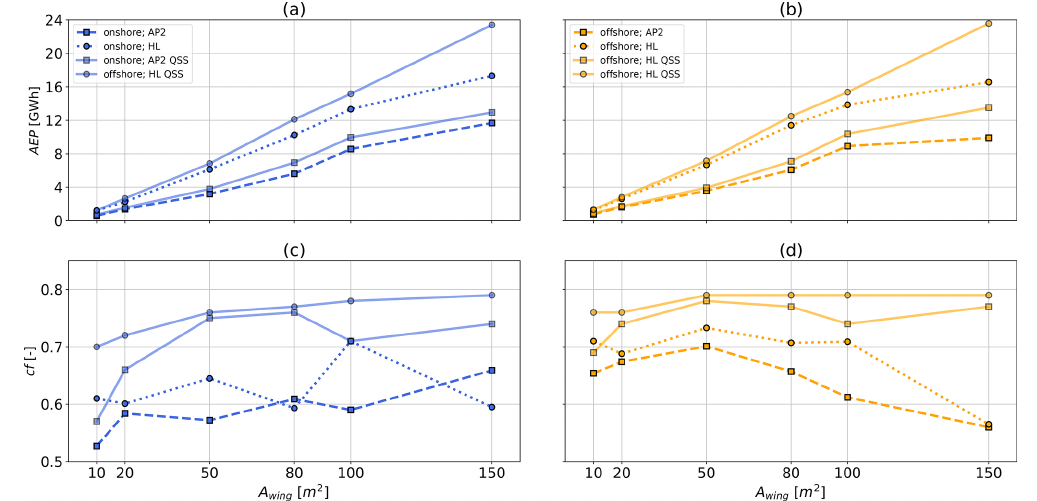
Figure 11. Representative AEP (a, b) and cf (c ,d) as functions of aircraft wing area A scaled according to Eqs. (6) and (7) with a mass exponent of κ = 2 . 7. QSM (solid lines) results are included for reference (Sect. 3.2). The diagrams summarize data for both sets of HL (circle) and AP2 (square) aerodynamic coefficients as well as both onshore (left, blue) and offshore (right, orange) locations. Results are based on the average cycle power P derived from p5, p50, p95 wind velocity profiles within each of the k = 10 WRF-simulated clusters and wind speed probability distribution between 100 ≤ z ref ≤ 400m, used as a proxy for wind speed at operating